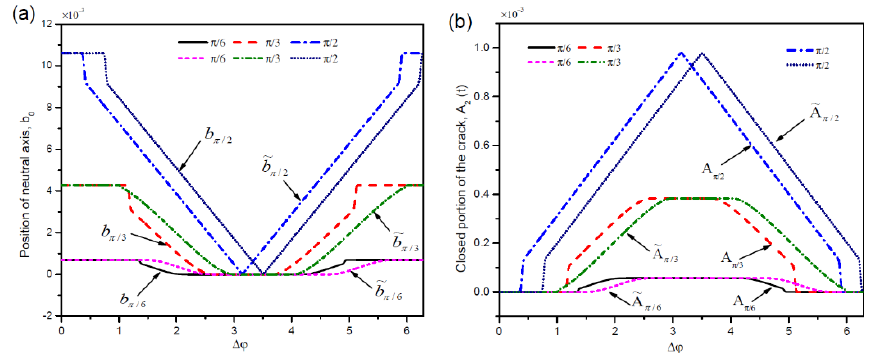
Figure 4. Displacement of neutral axis and area of closed portion of the crack. ( a ) neural axis, ( b ) closed portion of the crack. ( b ) closed portion of the